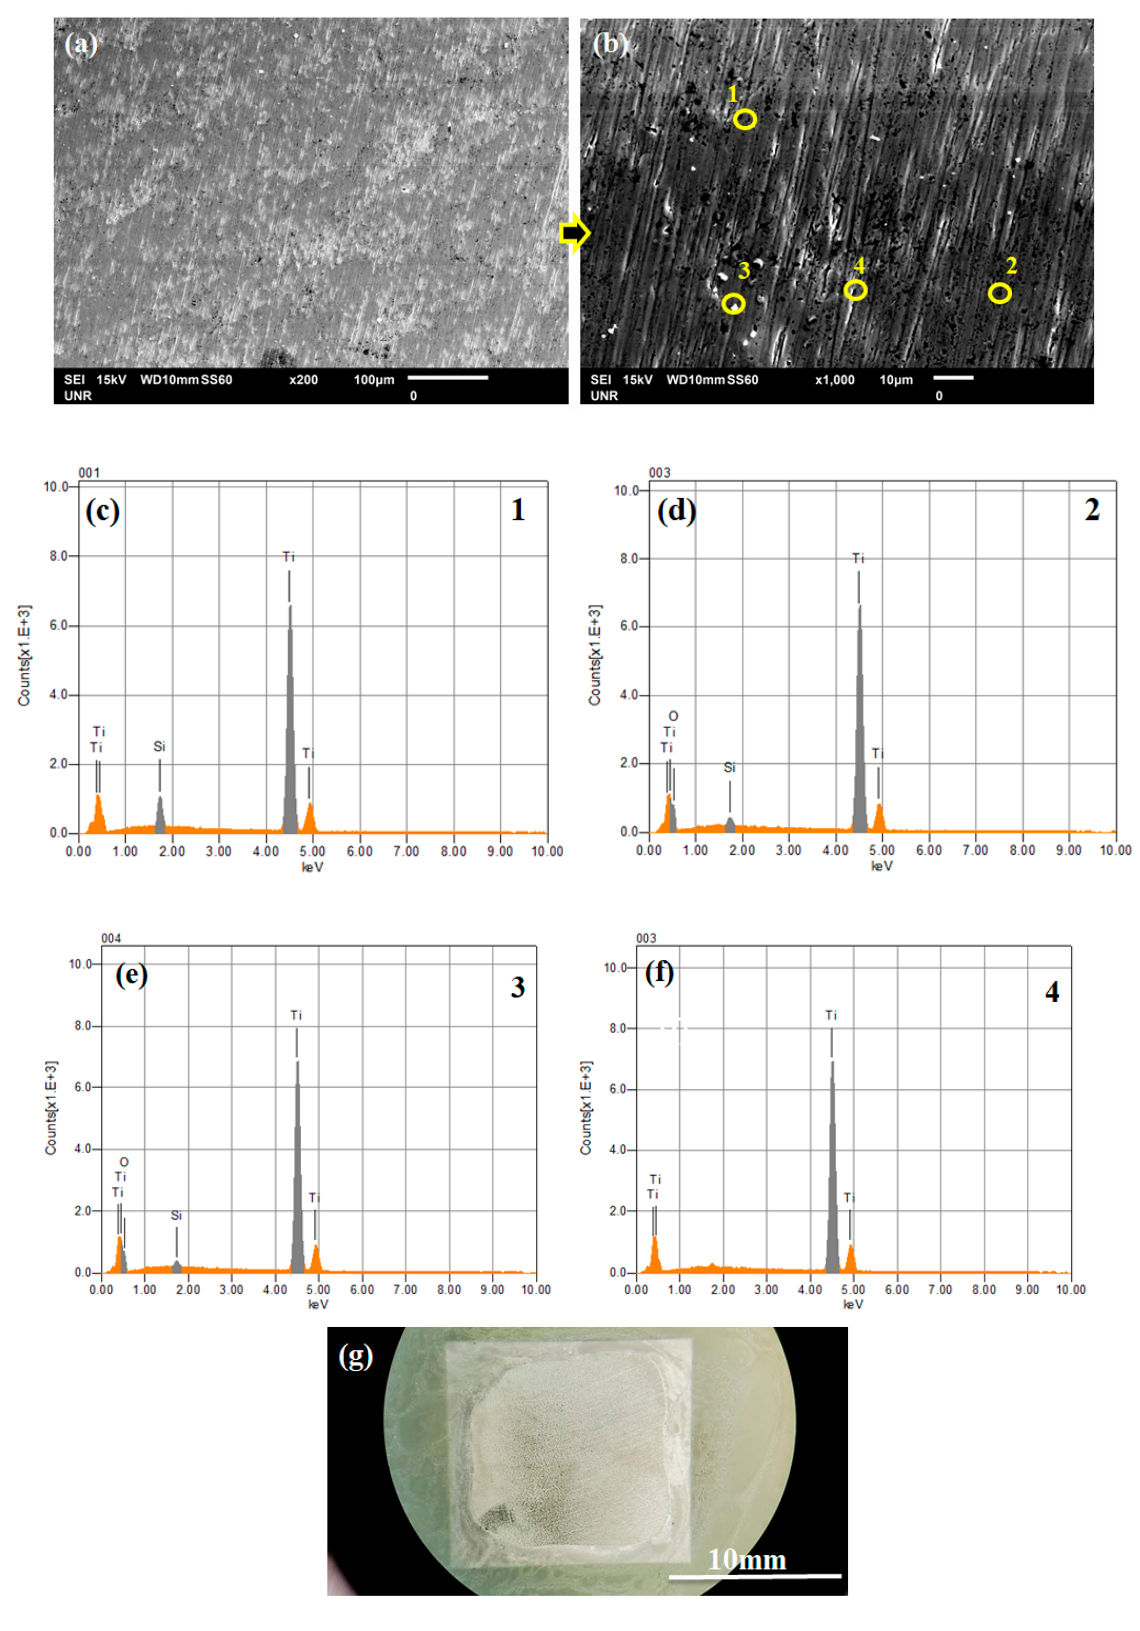
Figure 11. ( a , b ) surface morphology of ground surface of Ti-coated AZ31B after immersion test in 3.5 wt % NaCl solution for 11 days, EDS analysis of 1 ( c ), 2 ( d ), 3 ( e ), 4 ( f ) and ( g ) stereo microscope image at 50× magnification.